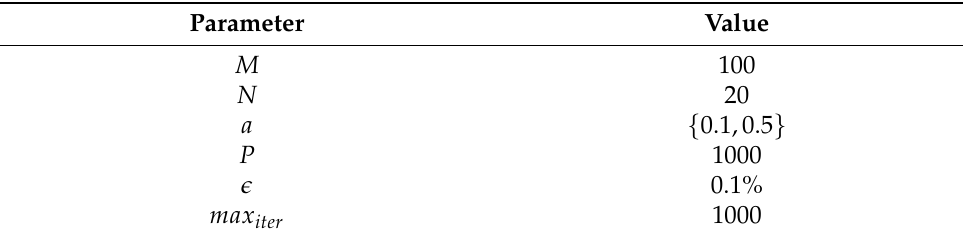
Table 2. Algorithm parameters.